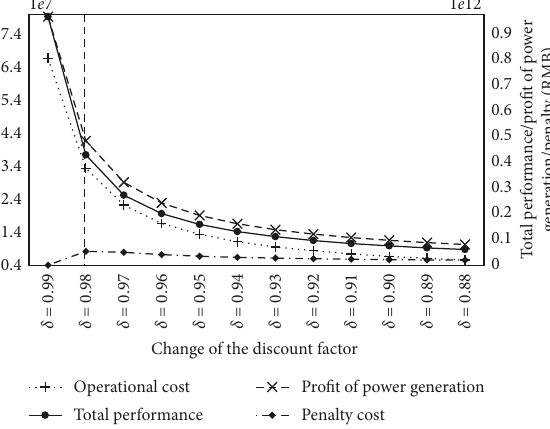
Figure 10: Cost and profit of power generation under the different discount factors.